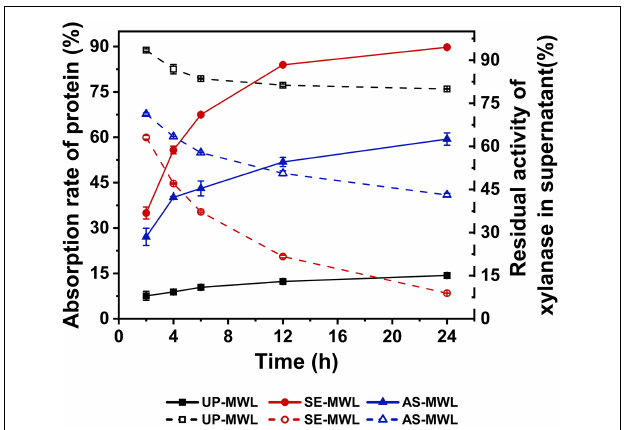
FIGURE 2 | The changes of adsorption rates of Xyn10A during adsorption with different lignins and residual activities of Xyn10A in supernatant after